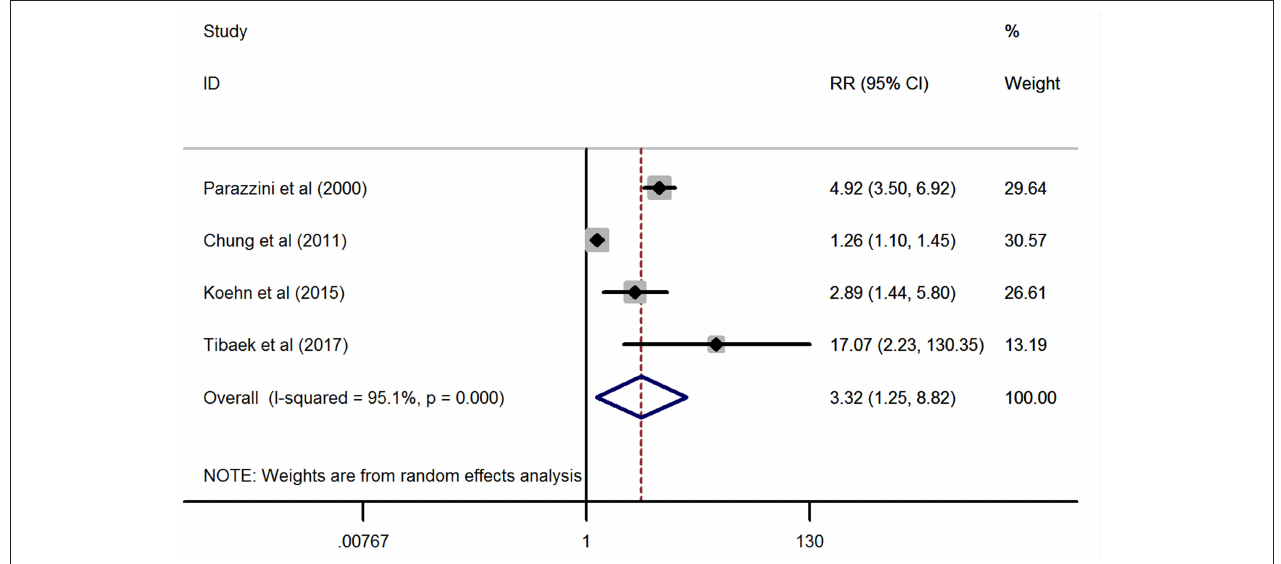
FIGURE 2 | Forest plots of the meta-analysis from the four eligible studies on the association between stroke and erectile dysfunction.